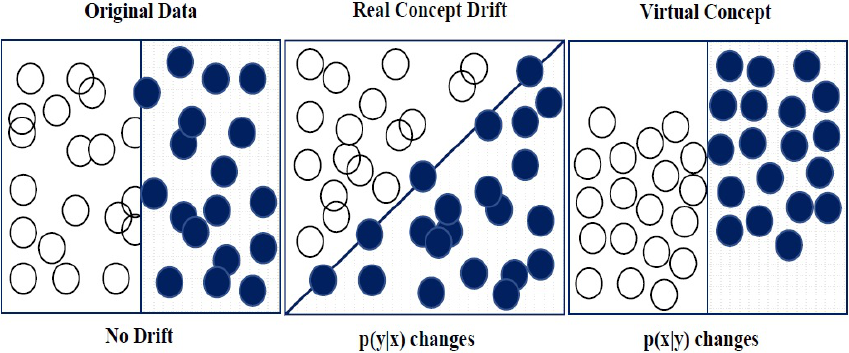
Figure 1. Types of drifts: circles represent instances, different colors represent different